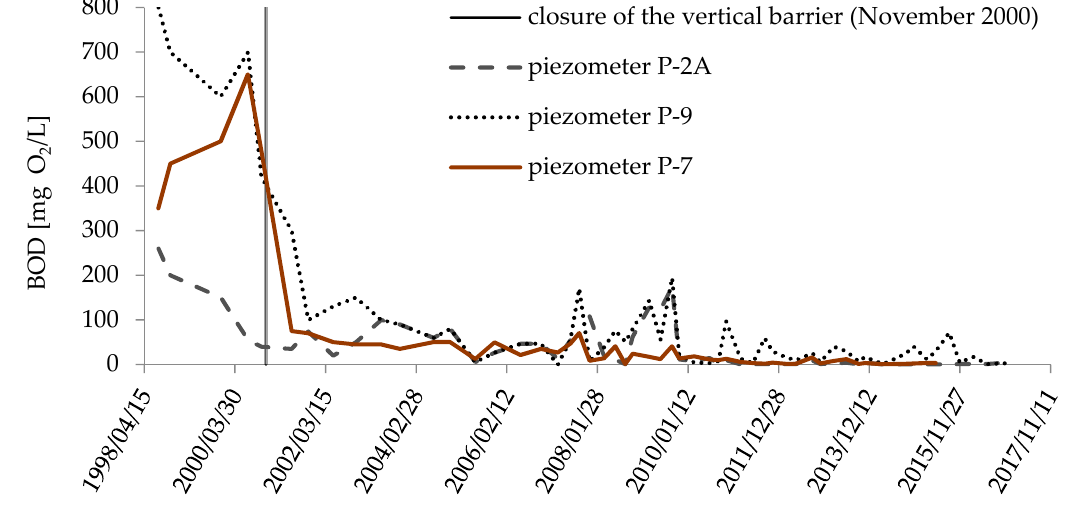
Figure 4. Temporal changes of the BOD level in piezometers located in the landfill area.